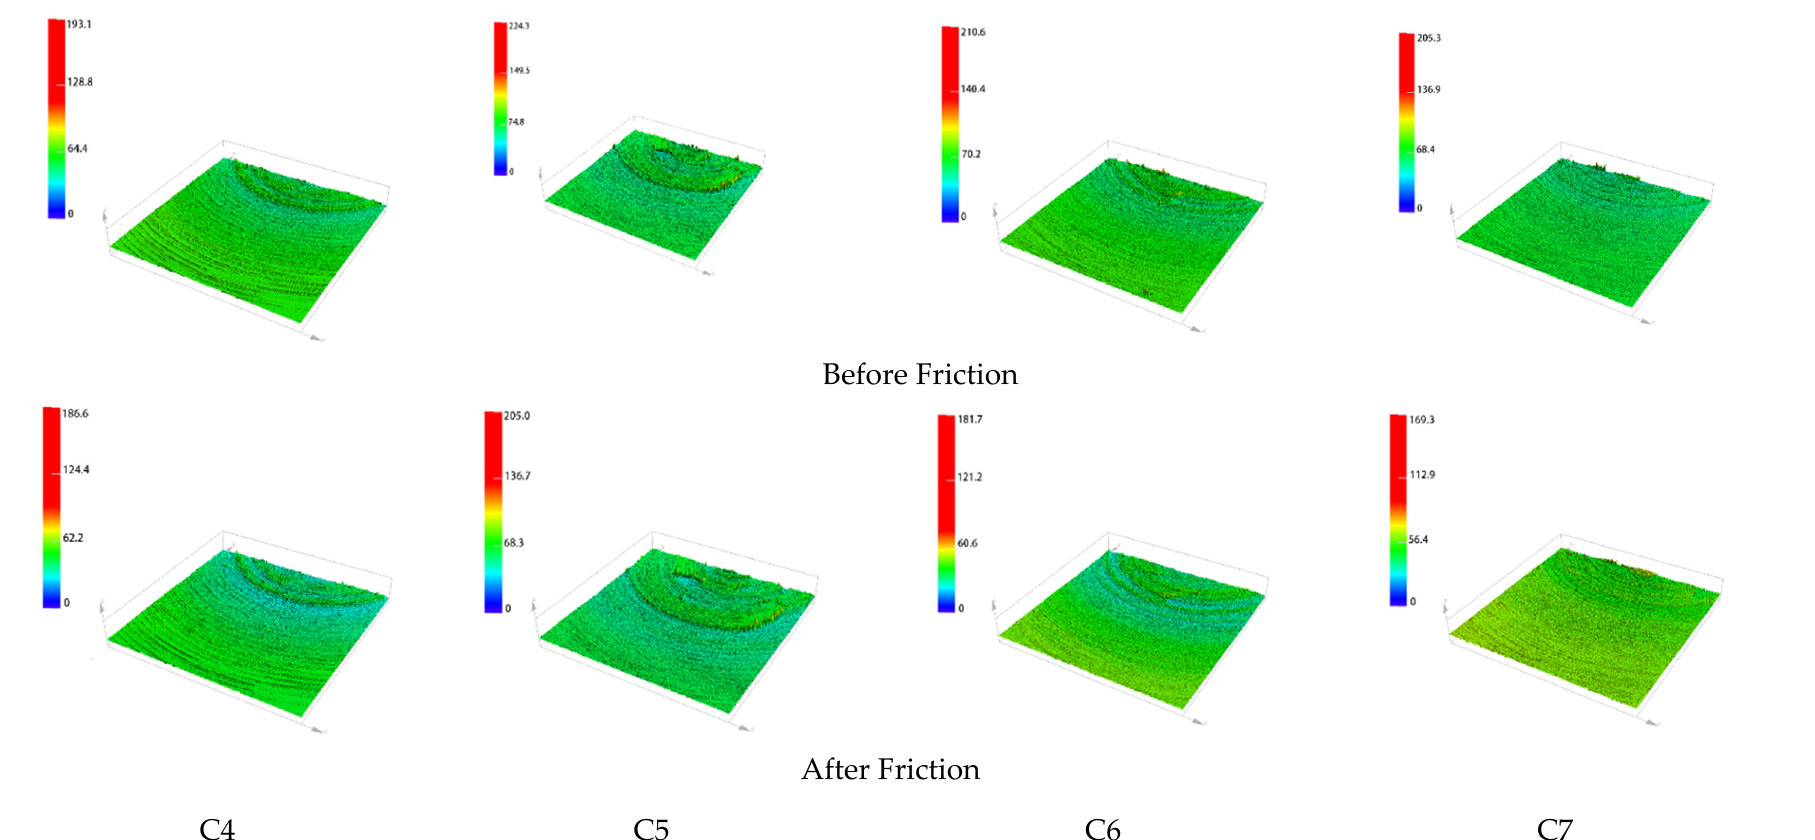
Figure 9. Metal surface 3D morphology. C1 ‐ C7 are the three ‐ dimensional surface morphologies of 7 groups of metals before and after friction.